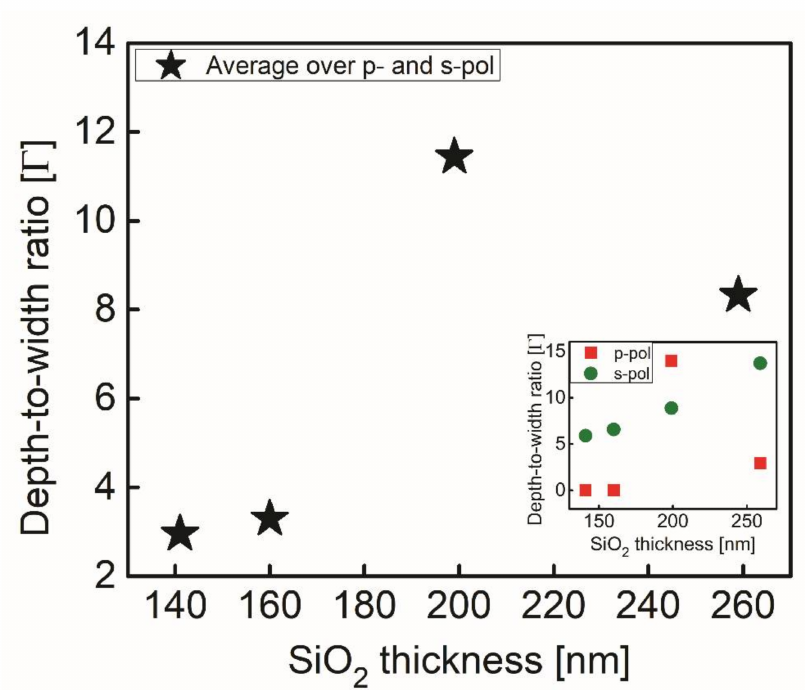
Figure 6. Average of depth-to-width ratio ( Γ ) of the reflectance dip over two polarizations (p and s) at each SiO 2 thickness. Inset shows Γ for p- and s-polarizations at each SiO 2